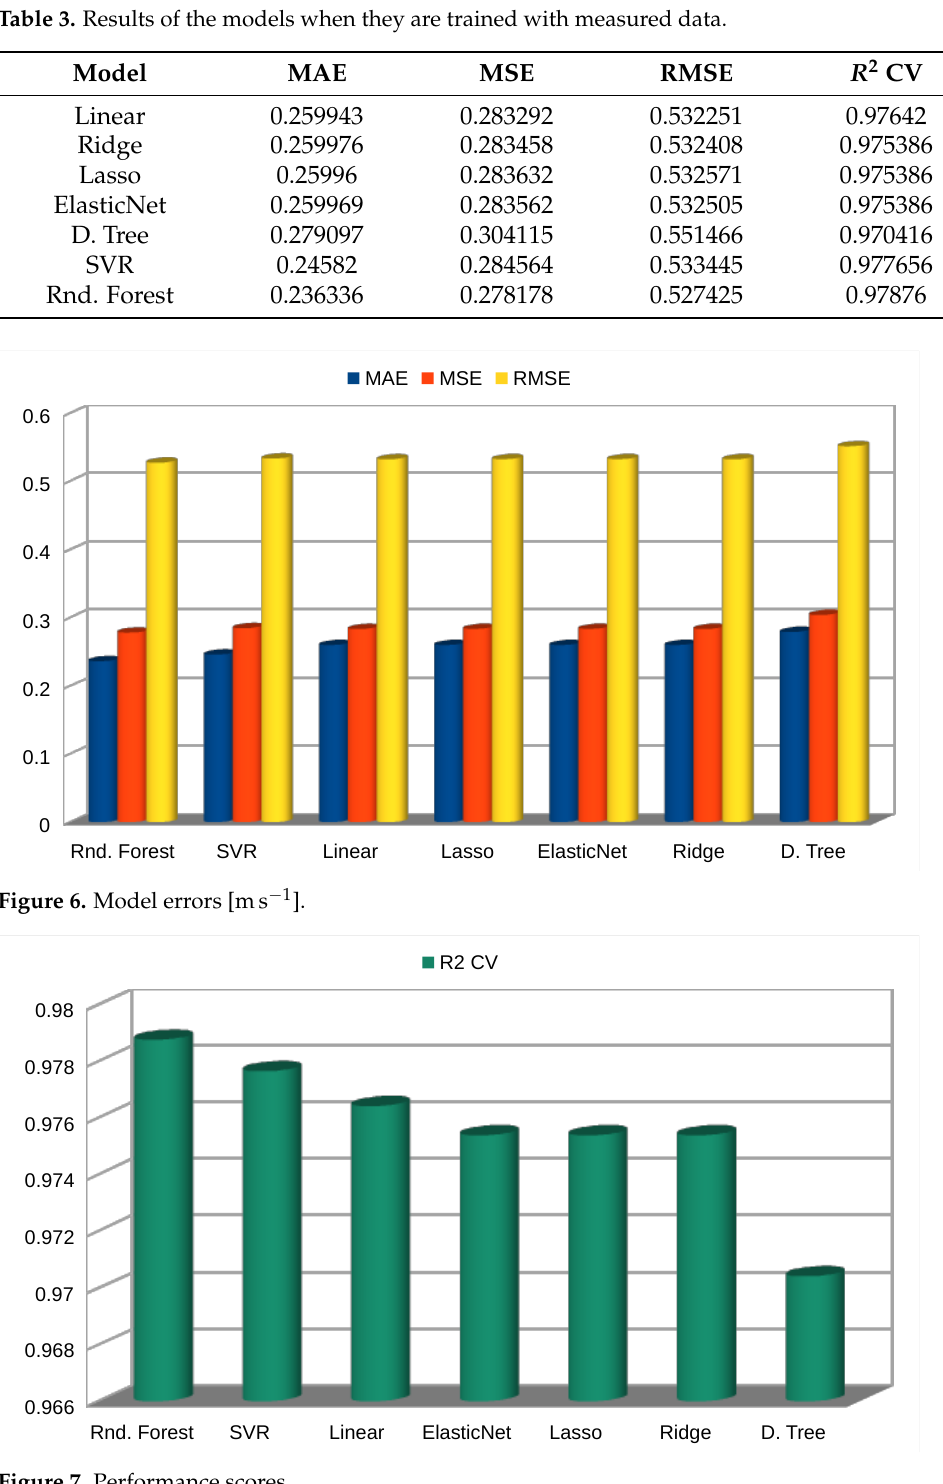
Figure 7. Performance